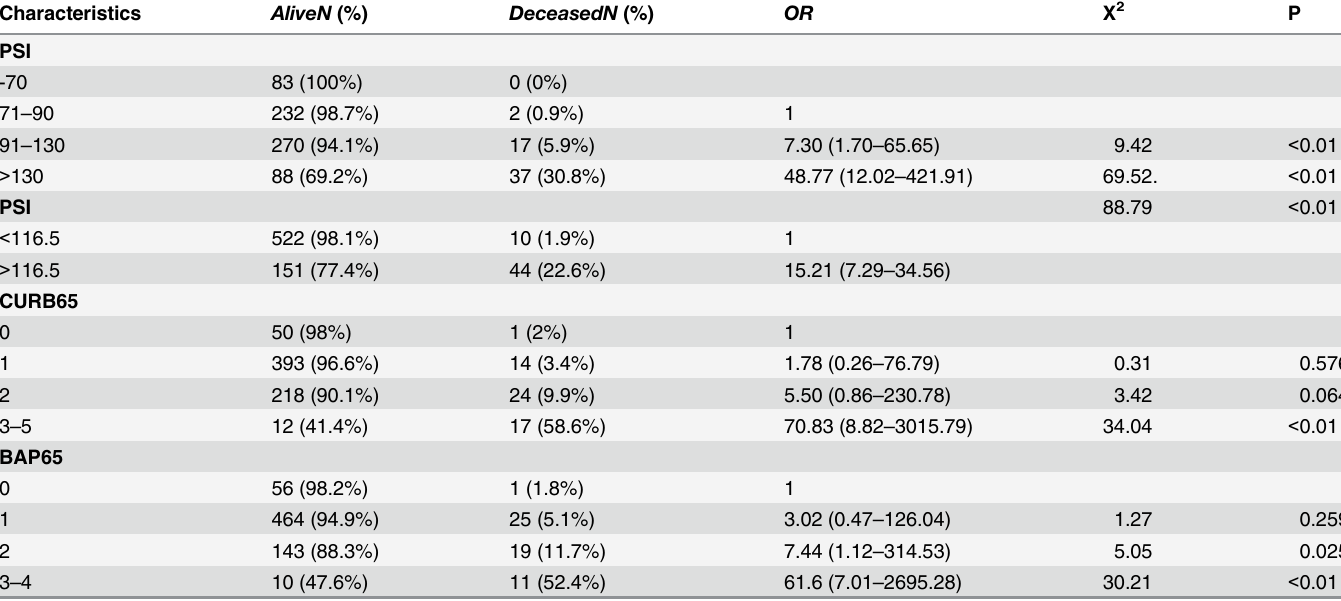
Table 6. Sub-group analysis of in-hospital mortality by the PSI, CURB65 and BAP65 score and risk groups for AECOPD when the patients who had met the criteria but did not receive the cure of IMV were excluded.